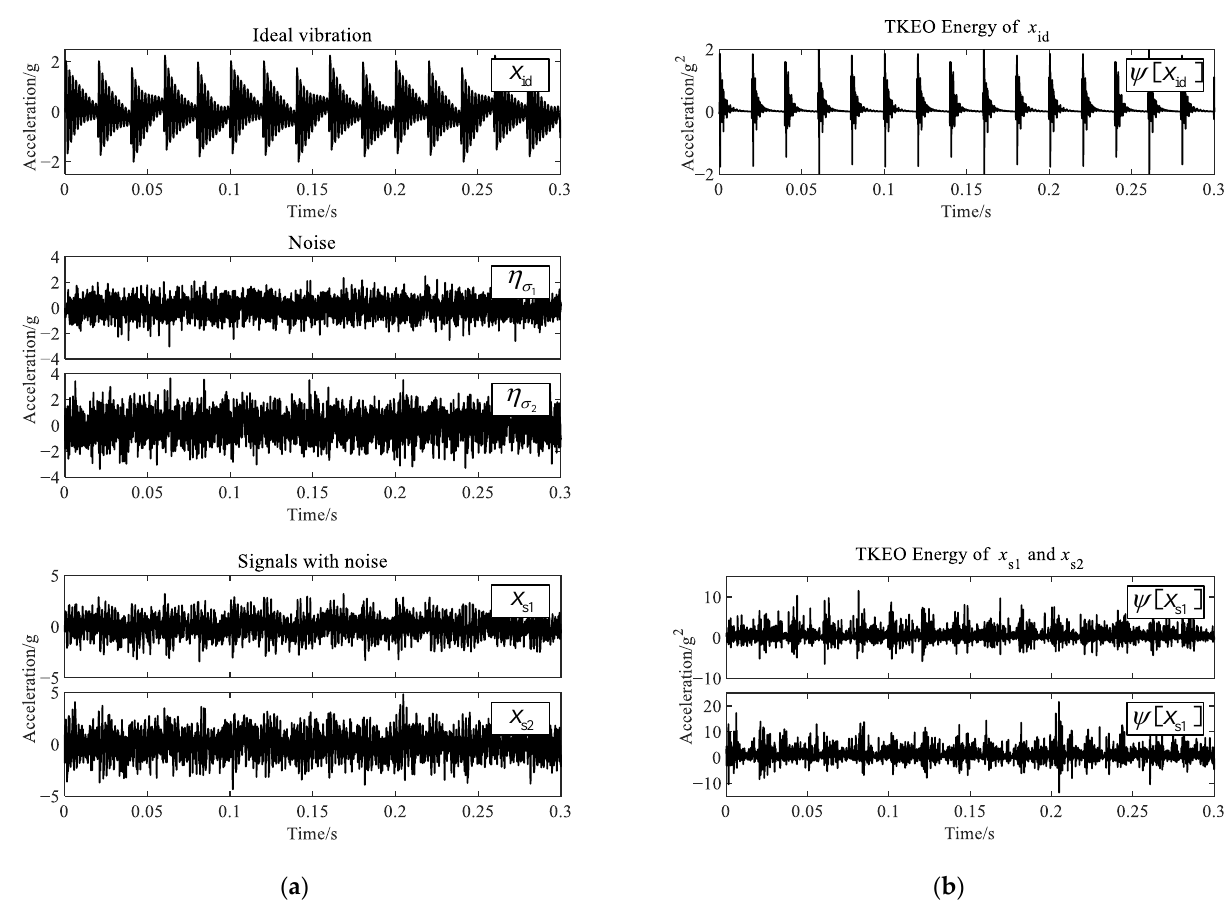
Figure 1. Waveforms of simulation signals and TKEO energy. ( a ) The ideal vibration signal, additive Gaussian noise and the signals with noise; ( b ) the TKEO energy of the ideal vibration signal and the signals with